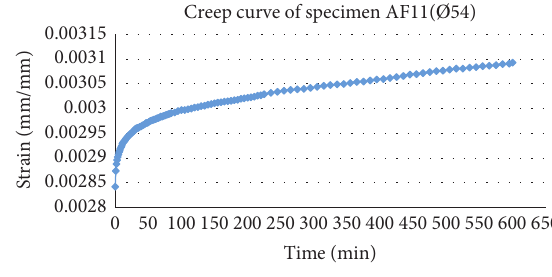
Figure 17: 10-hour creep curves of Ø54 specimens under a load of